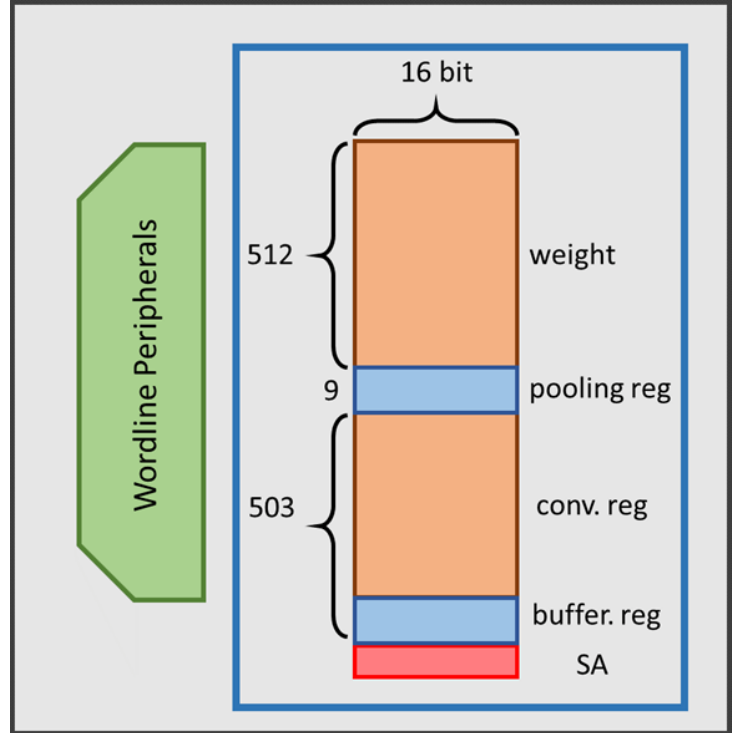
Figure 7. Storage unit configuration.